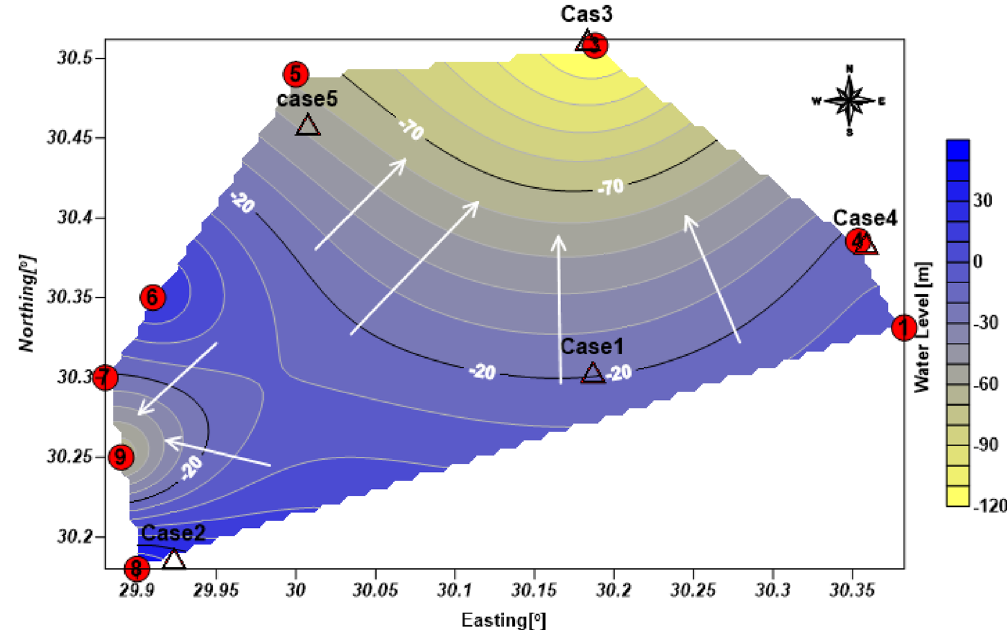
Figure 14. Simplified water level contour map of east and west Wadi El Natrun Depression, red circle represents available drilled wells with numbers and hollow triangle represents the location of case studies.